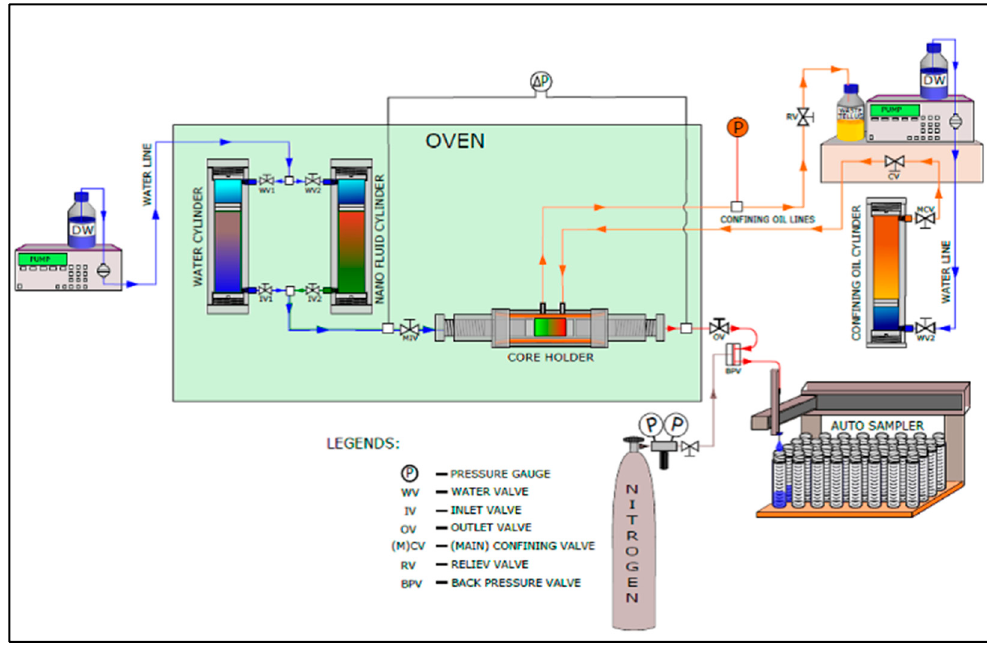
Figure 1. Schematic of the core flooding setup.